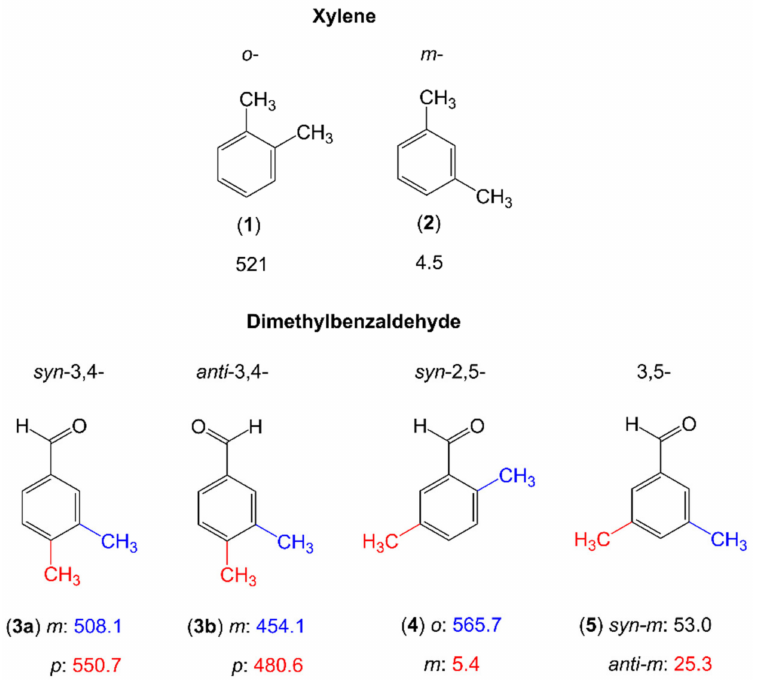
Figure 13. Barriers to methyl internal rotation in xylenes and dimethylbenzaldehydes (in cm − 1 ). ( 1 ) o-xylene [196], ( 2 ) m-xylene [197], ( 3 ) 3,4-dimethylbenzaldehyde [81], ( 4 ) 2,5-dimethyl- benzaldehyde [81], 3,5-dimethylbenzaldehyde